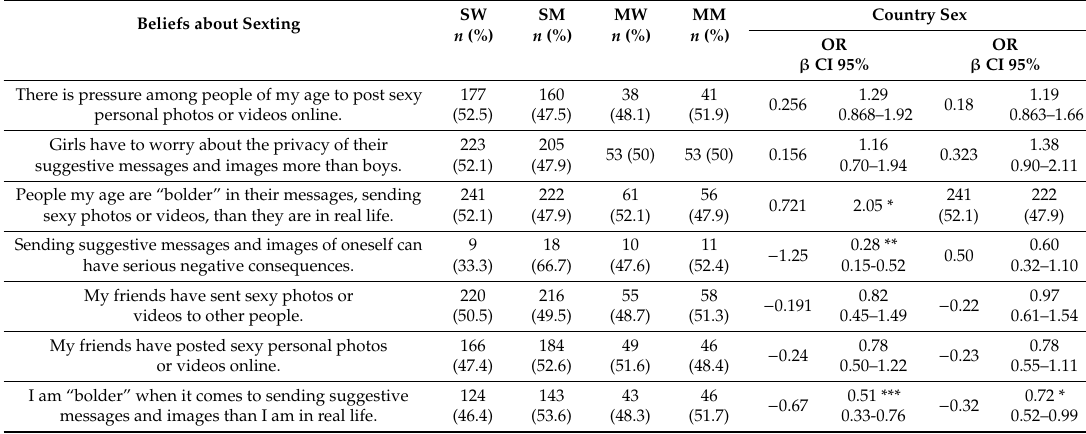
Table 1. Beliefs about sexting in Spanish and Moroccan adolescents. SW: Spanish women; SM: Spanish men; MW: Moroccan women; MM: Moroccan men. Beliefs about Sexting SW